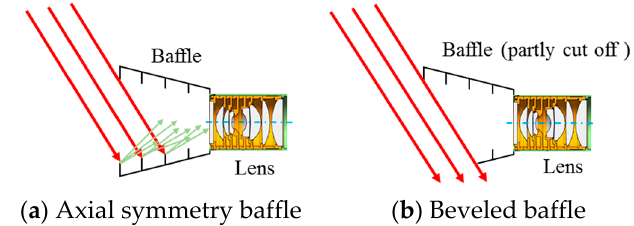
Figure 7. Principle of special-shaped baffle.